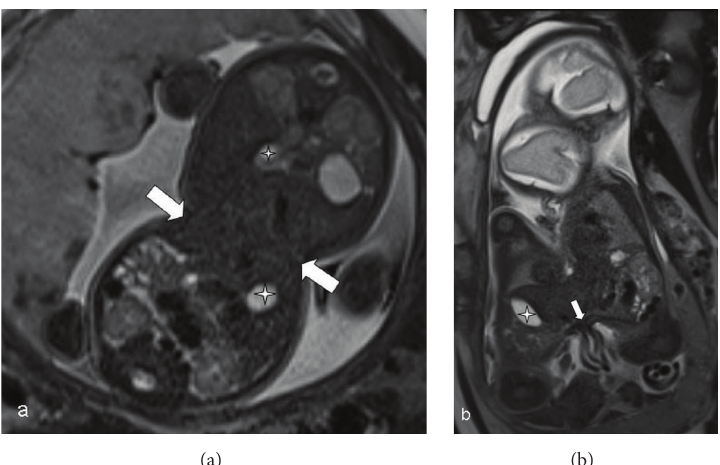
Figure 1: Axial (a) and coronal (b) T2-HASTE images show conjoined twins sharing liver (white arrows) at the level of umbilicus (a) with a common umbilical cord (small white arrow) (b) and two gallbladders (stars) (a, b).